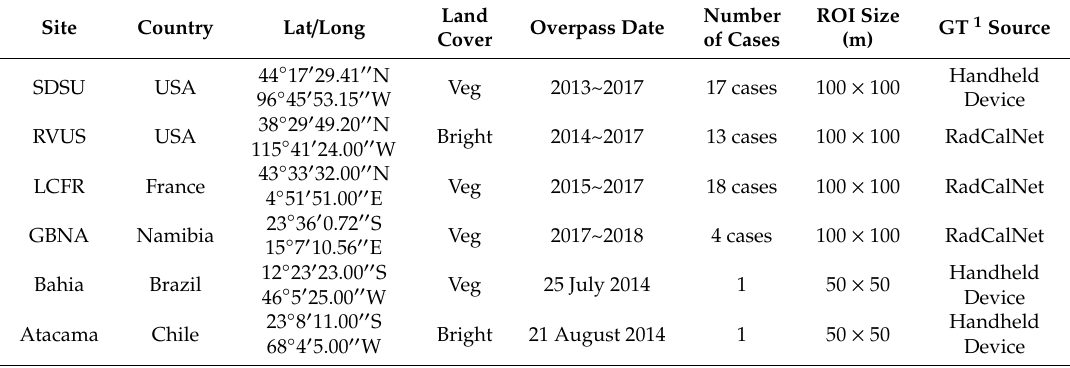
Table 2. Ground truth sites metadata for the OLI Level 2 Surface Reflectance product